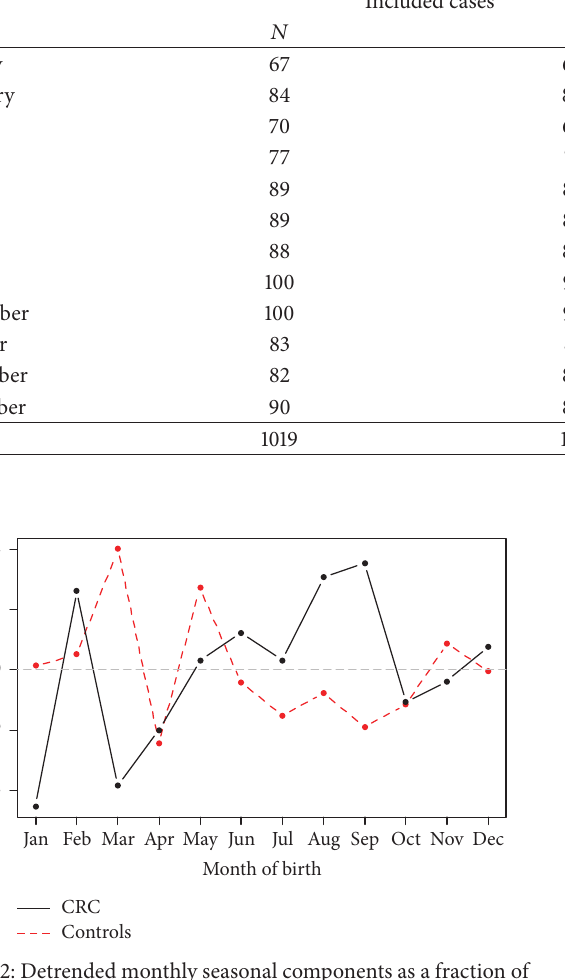
Figure 3: Detrended seasonal components for male CRC and controls as a fraction of their means. The average increase of risk between the spring and the autumn peak of the detrended seasonal components was 13% for men. In men, the spring trough remains but two peaks are noted in September and another one in